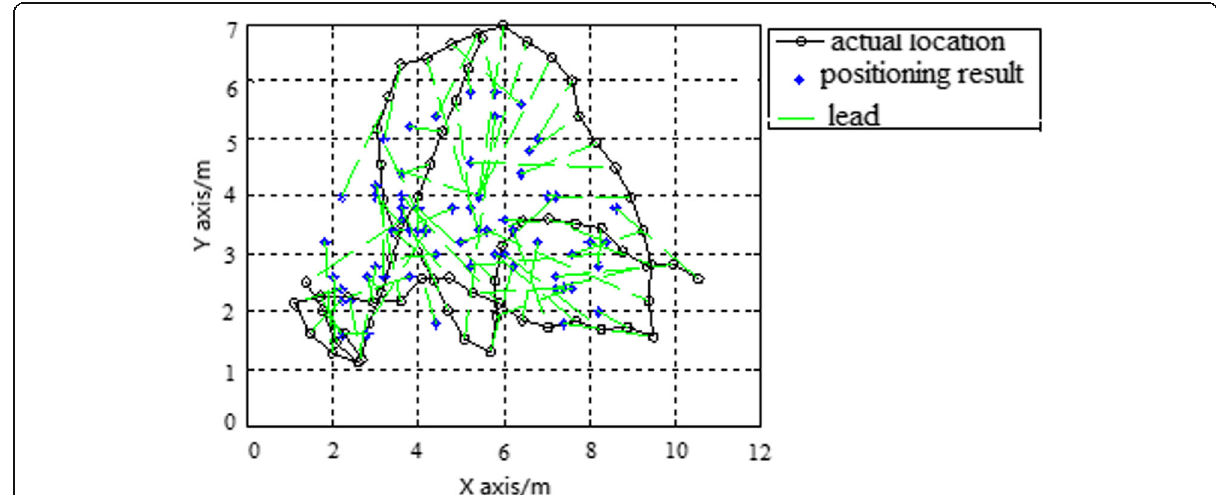
Fig. 6 The result of positioning analysts based on traditional KNN